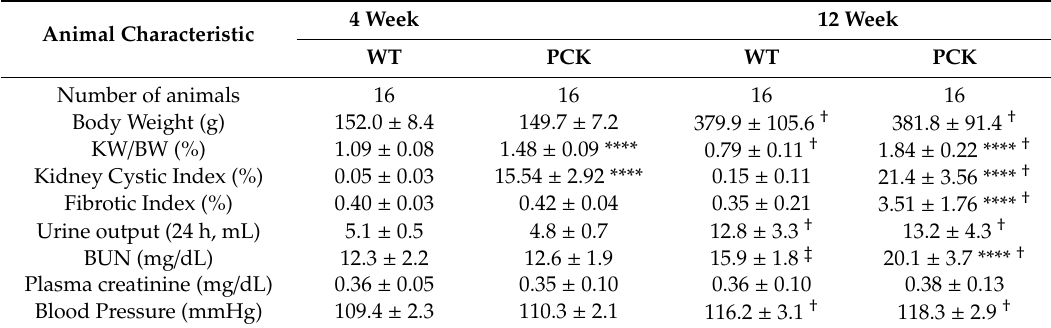
Table 1. Animal characteristics and renal function at 4 and 12 weeks in wild-type (WT) and PCK rats. Animal Characteristic